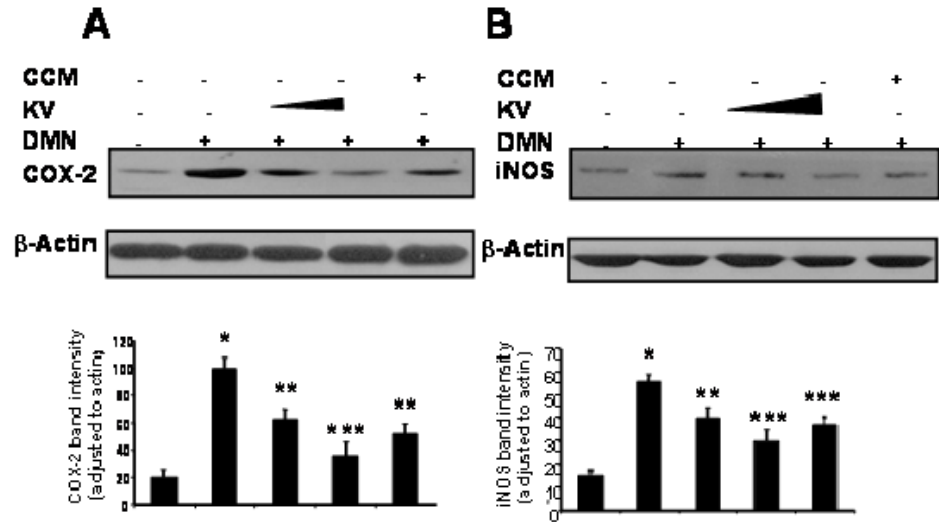
Figure 9. Inhibitory effect of kolaviron and curcumin on DMN induced COX-2 expression in rat liver (Adapted from Farombi et al.